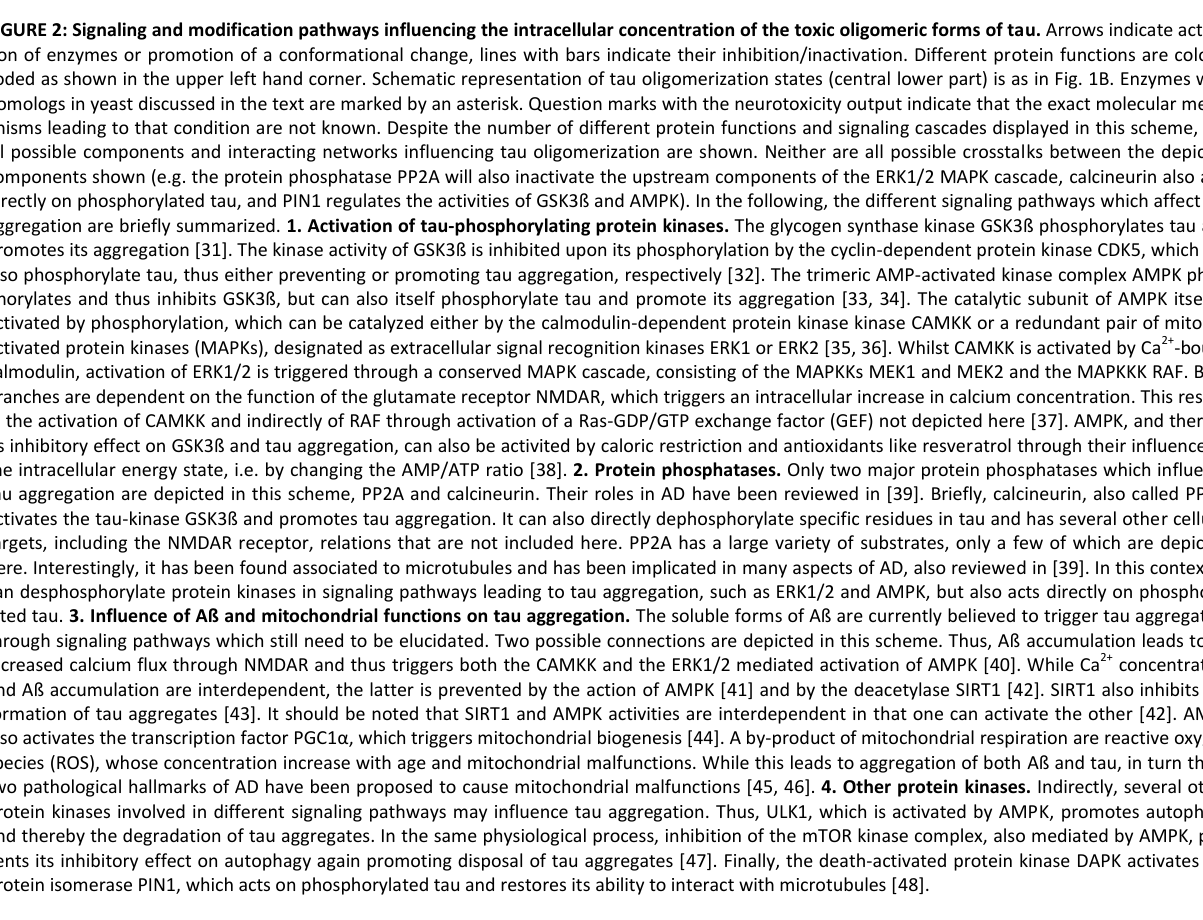
138 Microbial Cell | April 2016 | Vol. 3 No. 4